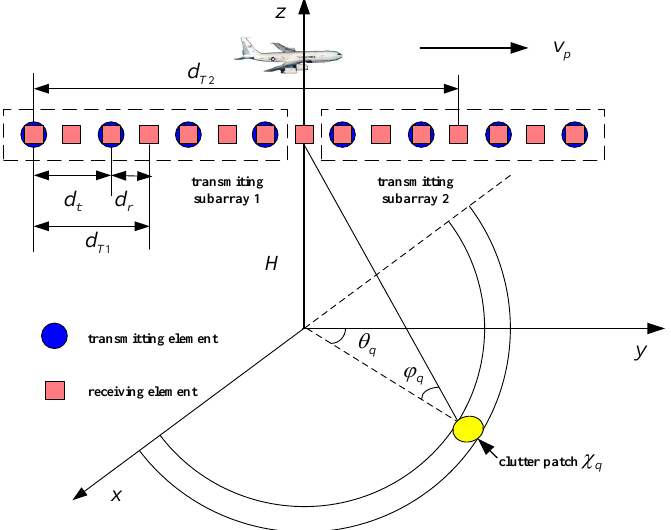
Figure 1. Spatial geometric relation of the airborne active side-looking array based on the transmitting subarray diversity.